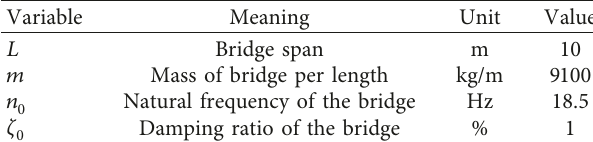
Table 1: Parameters of the simply supported